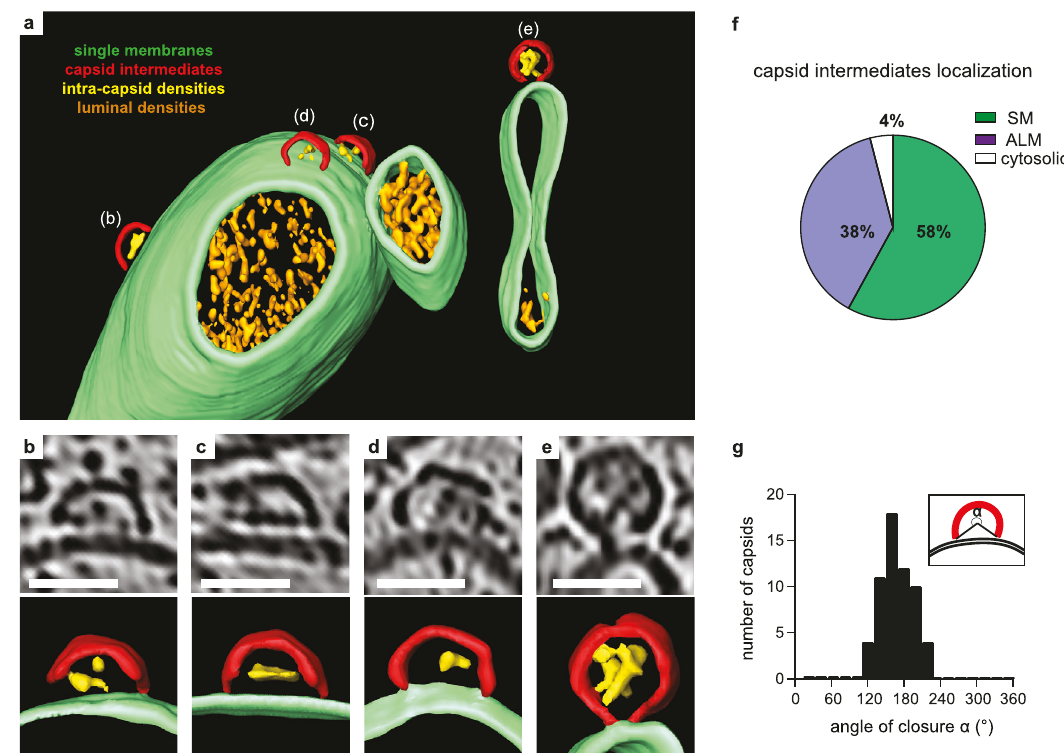
Fig. 2 | A membrane-bound capsid intermediate. a 3D segmentation of a tomo- gram showing capsid assembly intermediates, containing luminal densities, directlyboundtosingle-membranetubules(correspondingsliceinSupplementary Fig. 3a, b). b – e Zoomed tomogram slices and segmentations of the capsids assembly intermediates marked in ( a ). f Percentage of capsid assembly